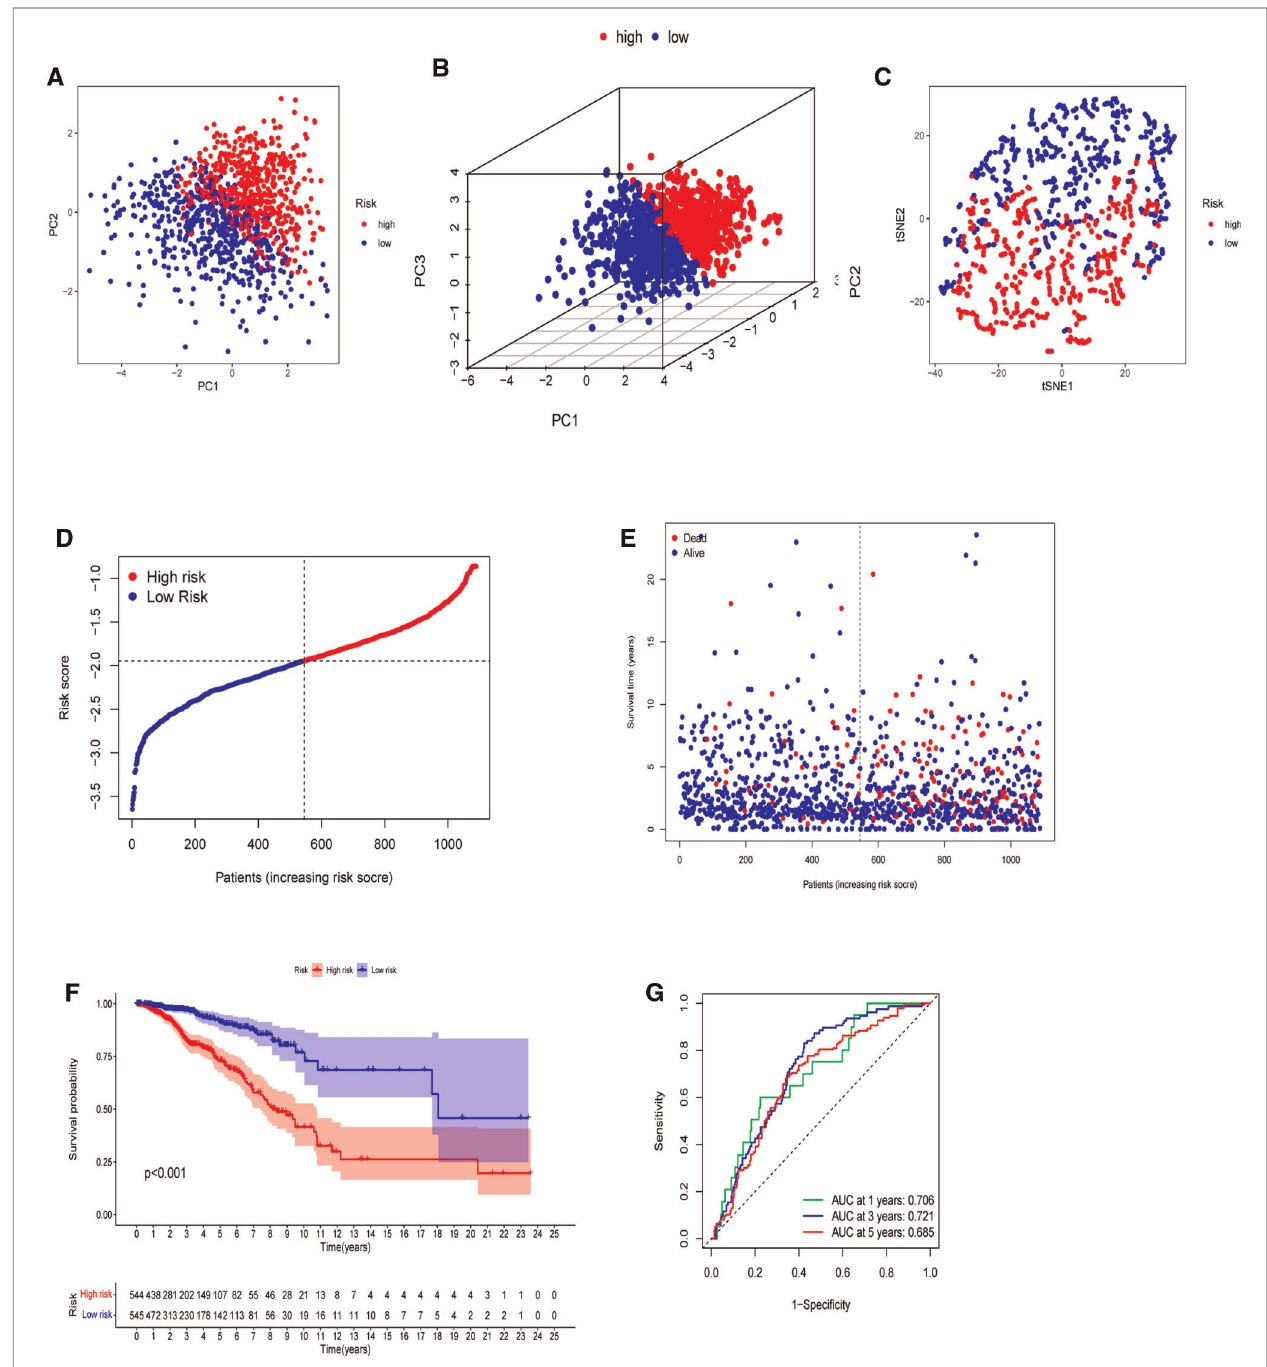
FIGURE 5 | Establishment of a fi ve-gene predictive signature in the TCGA-BRCA cohort. ( A ) Two-dimensional principal component analysis (2D PCA) plot. ( B ) Three- dimensional principal component analysis (3D PCA) plot. ( C ) t-distributed stochastic neighbor embedding (t-SNE) analysis. ( D ) Distribution of calculated risk scores. ( E ) Survival status of BC patients. ( F ) Kaplan – Meier curves of high- and low-risk subgroups. ( G ) Time-dependent receiver operating characteristic (ROC)